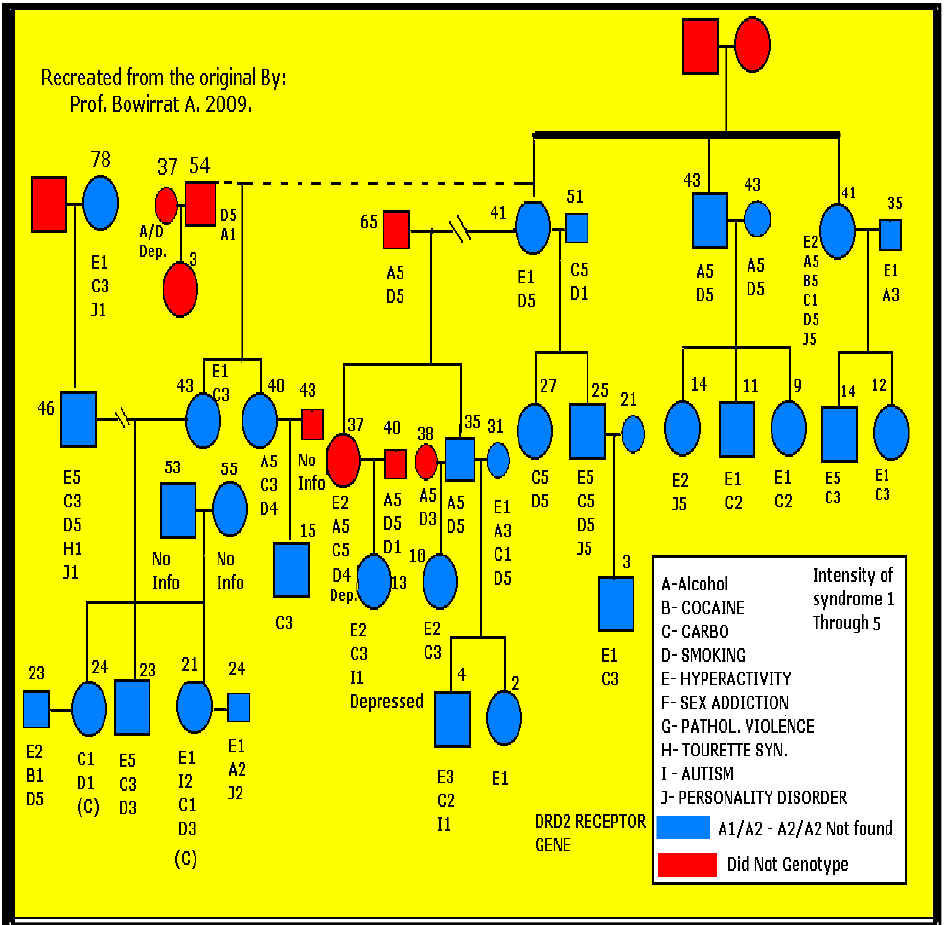
Figure 1. Genotype results of the Dopamine D2 receptor gene (DRD2) polymorphism of family A (n = 32) identified with multiple Reward Deficiency Syndrome (RDS)